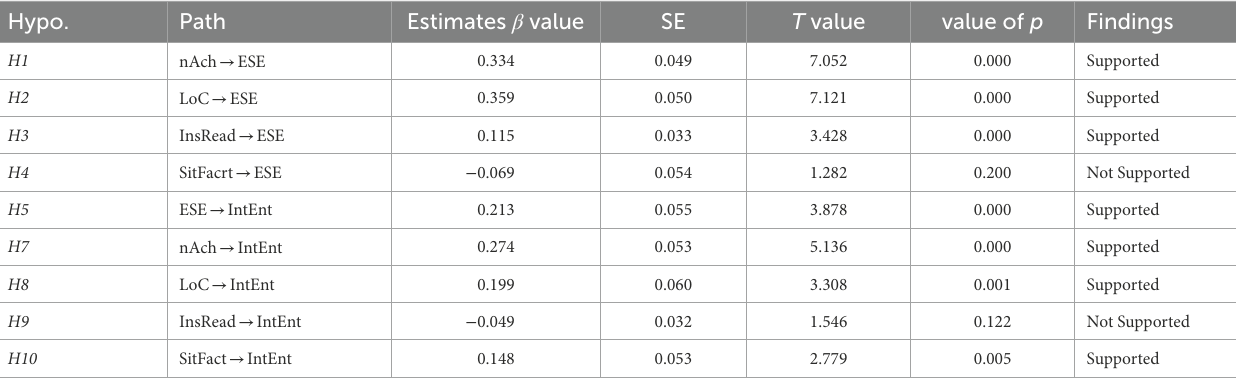
TABLE 9 Direct hypotheses testing.